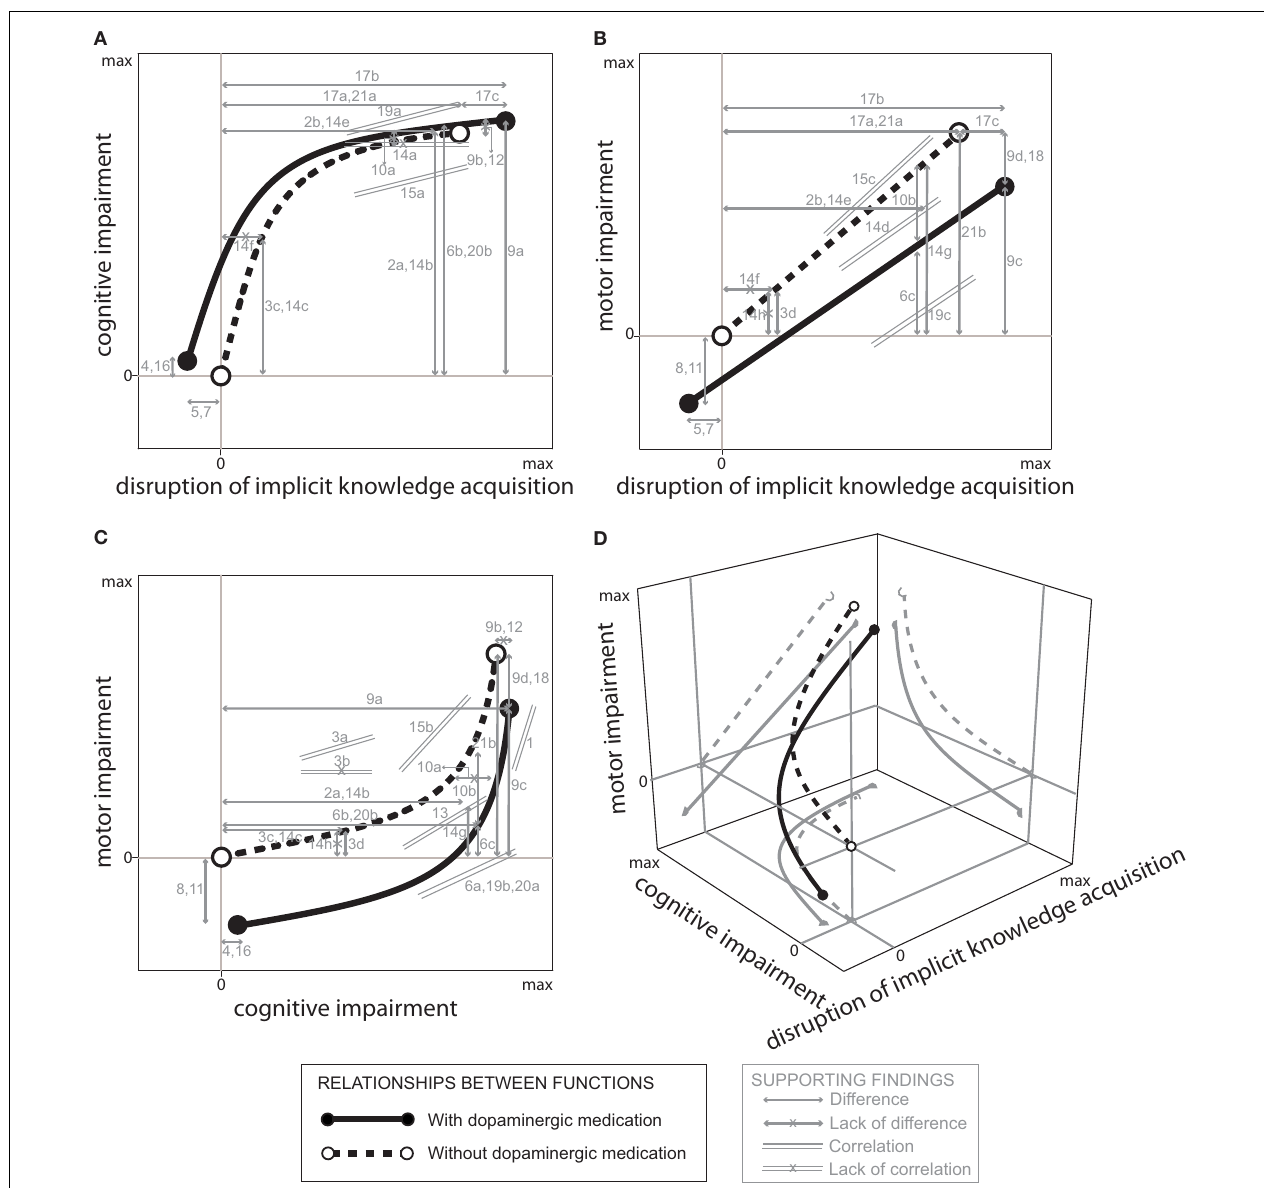
FIGURE 1 | Model showing the relationships between cognitive impairments as a function of disruption of implicit knowledge acquisition (general findings better adjusted to an arc-tangent function) (A), motor impairment as a function of disruption of implicit knowledge acquisition (general findings better adjusted to a linear function) (B), motor impairment as a function of cognitive impairment (general findings congruent with the other functions) (C), and an unified tri-dimensional model expressing the interaction between motor impairment, disruption of implicit knowledge acquisition, and cognitive impairment (D), in healthy volunteers (represented by the lines corresponding to the “zero” cognitive impairment, the “zero” disruption of acquisition of implicit knowledge and the “zero” motor impairment, tested without dopaminergic medication) and patients with PD tested with and without dopaminergic medication effects along disease progression up to a